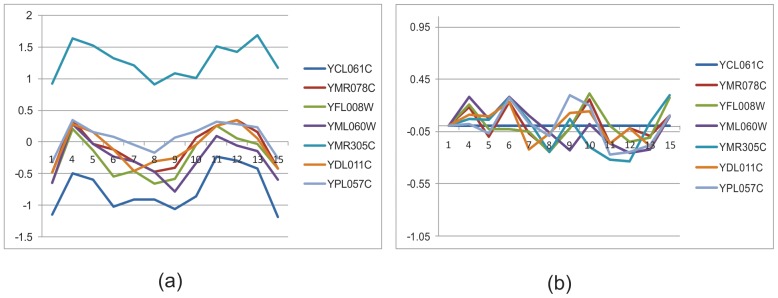
Gene expression level in absolute scale (a) and relative scale (b) after removing non-coherent time points.